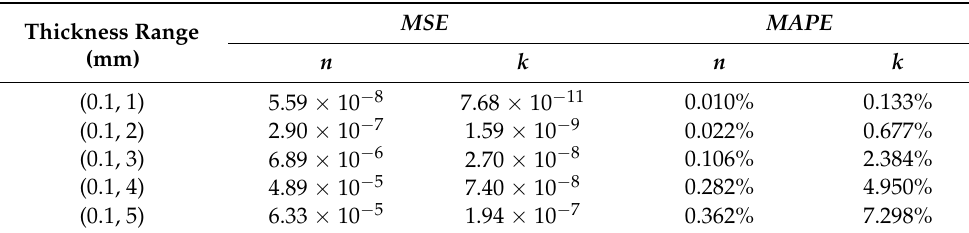
Table 2. MSE and MAPE values for n and k with sample thickness as a variable with different ranges. Thickness